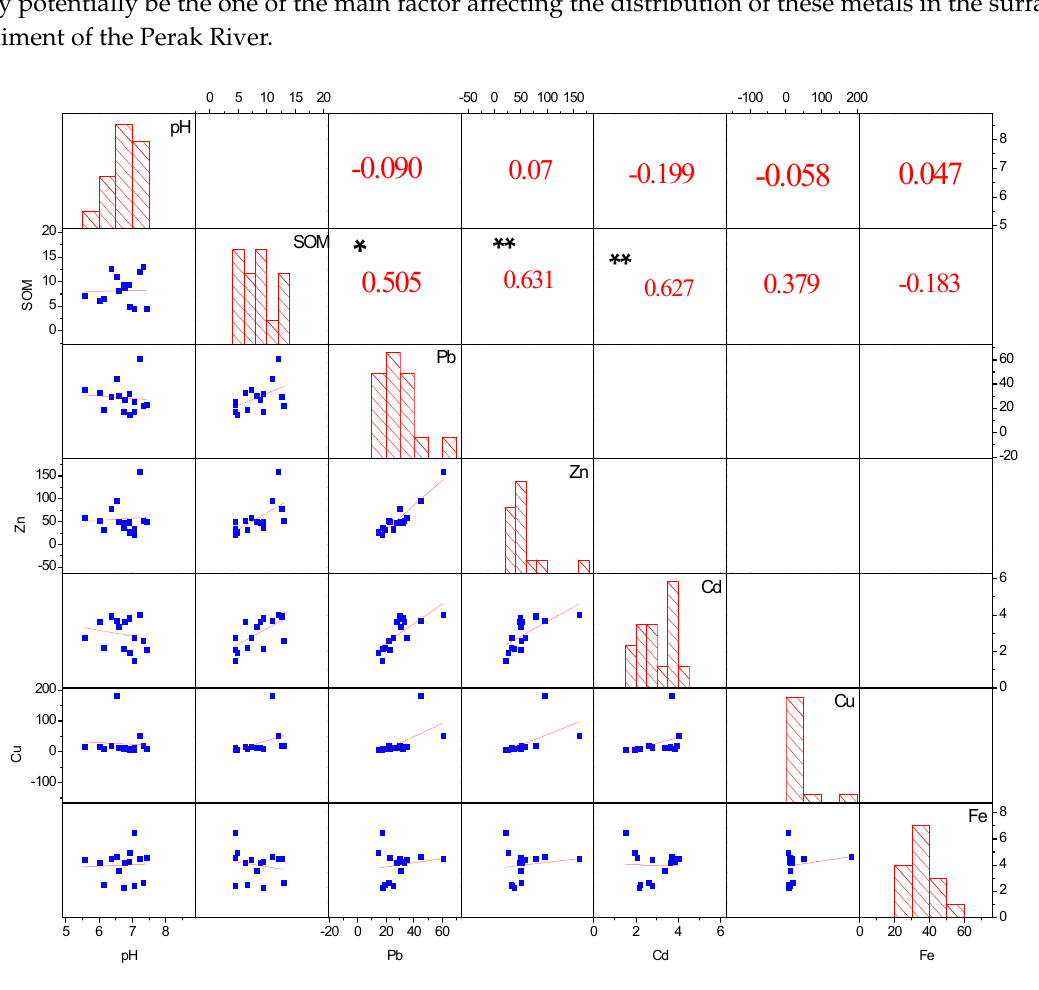
Figure 3. Correlation of heavy metal concentration with pH and sediment organic matter content (SOM) ** Correlation is significant at the 0.01 level (2 ‐ tailed) * Correlation is significant at the 0.05 level (2 ‐ tailed).